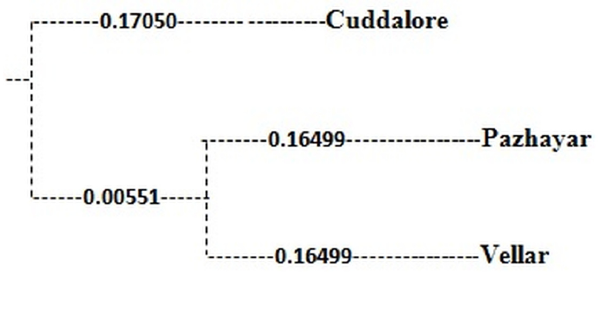
Fig. 3. Neighbour joining tree (1000 replications) generated from RAPD data of the